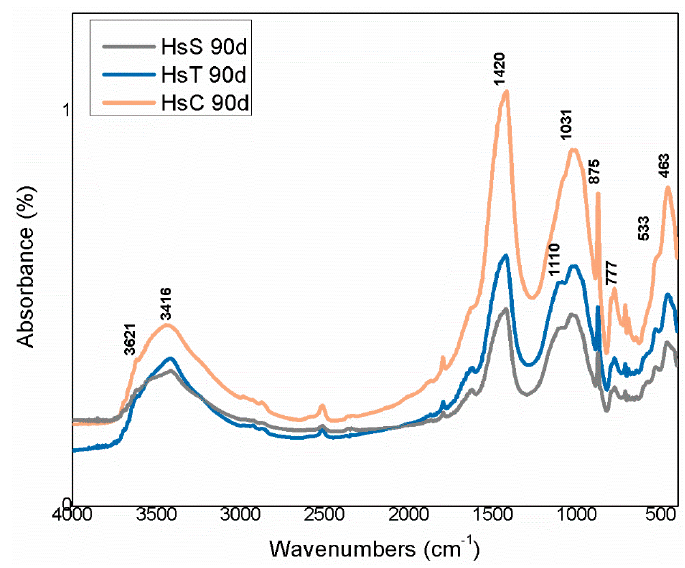
Figure 19. FTIR spectra for 90 days Hs waste.